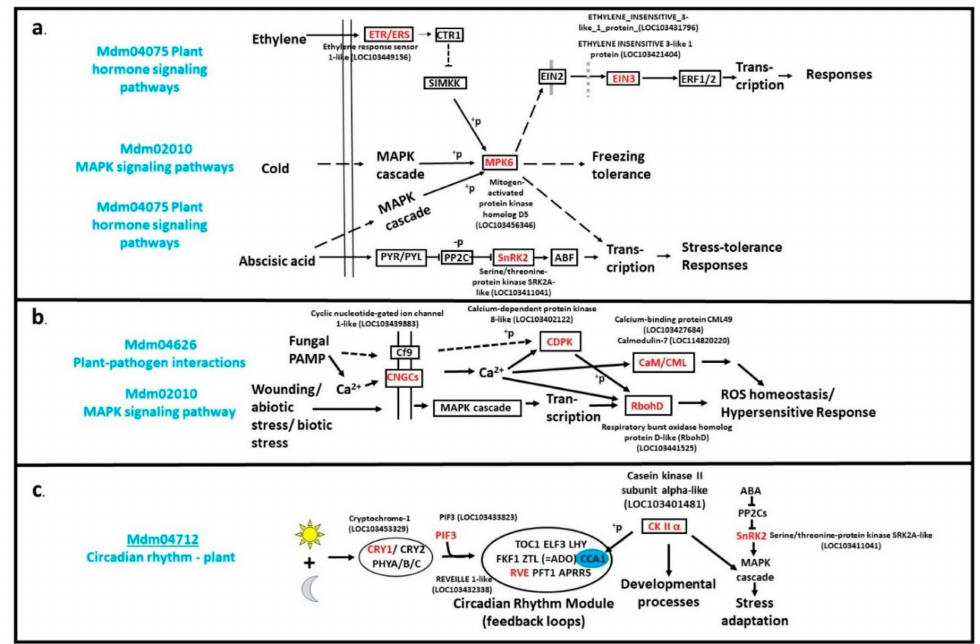
Figure 2. KEGG GO pathways of selected apple Full-length cDNA OvereXpressing (FOX) Arabidopsis mutant lines. Pathways reflect known genes from Malus × domestica but are not necessarily specific to M . × domestica . Gene names in red indicate apple FOX inserts. ( a ) Plant hormone signaling pathways and MAPK / cold signaling pathway. ( b ) Plant pathogen and MAPK signaling pathways. ( c ) Plant circadian rhythm pathways. Adapted from KEGG